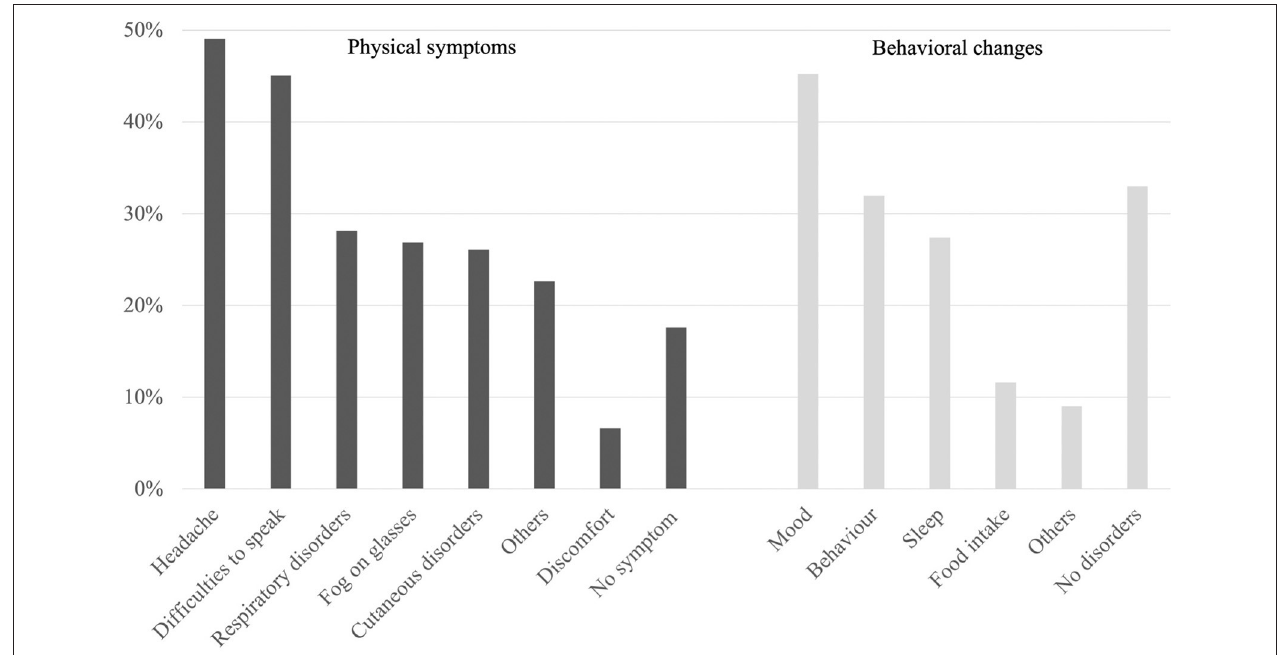
FIGURE 1 | Physical symptoms and behavioral changes attributed to mask-wearing (parents’ survey).